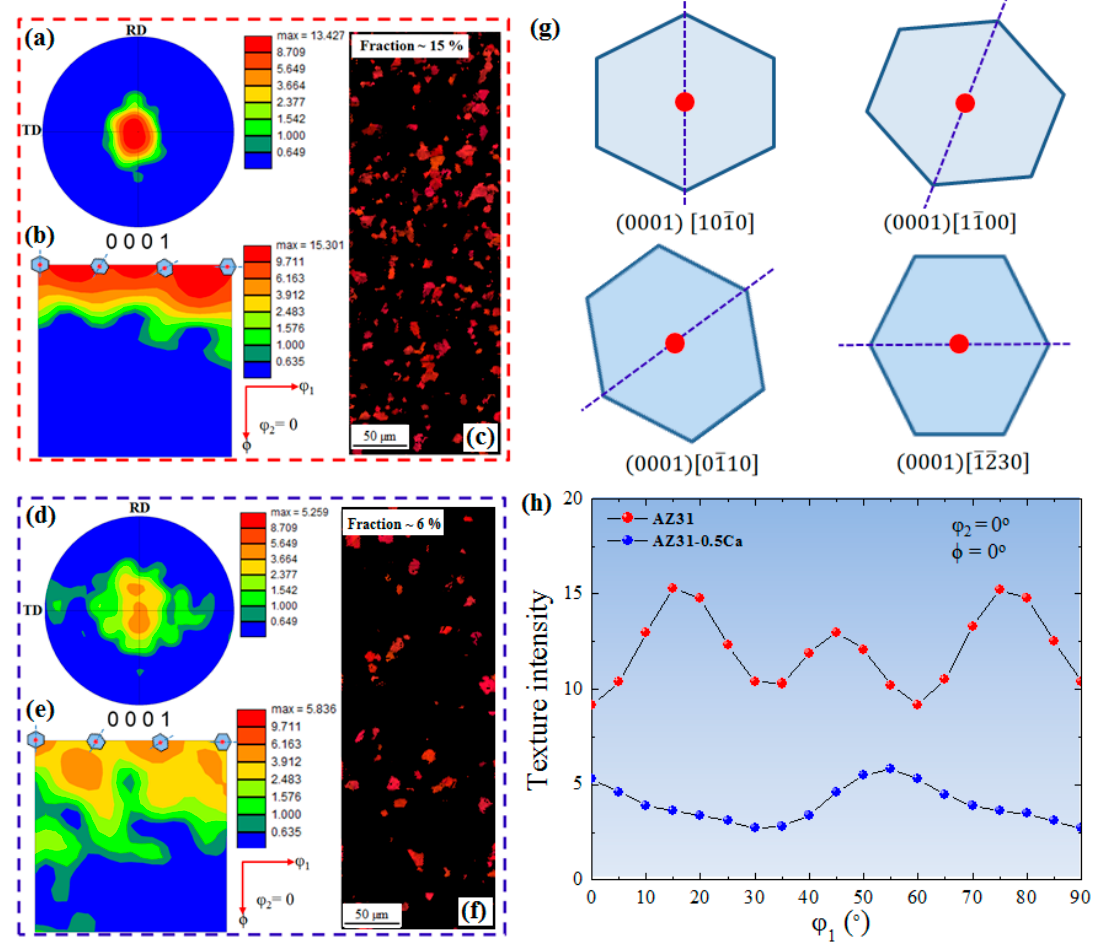
Figure 3. ( a , d ) Pole figures; ( b , e ) orientation distribution function; and ( c , f ) ND inverse pole figure maps of partitioned basal grains of the AZ31 and AZ31-0.5Ca alloys, respectively; ( g ) The main orientations of the basal texture; ( h ) Orientation distribution function intensity of the two alloys along φ 1 ( φ 2 = 0°, Φ = 0°).